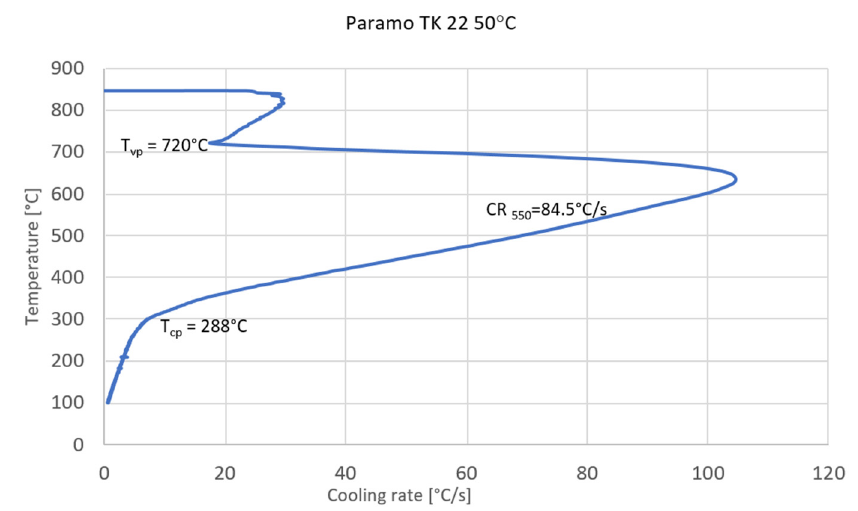
Figure 4. Paramo TK 22 parameters found from the cooling curve. Table 4. Hardening power for individual oils.